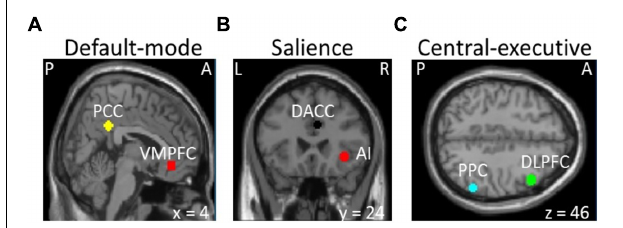
FIGURE 1 | Selection of the (A) default-mode (VMPFC, ventromedial prefrontal cortex; PPC, posterior cingulate cortex), (B) salience (AI, insula; DACC, dorsal anterior cingulate cortex), and (C) central-executive (DLPFC, dorsolateral prefrontal cortex; PPC, posterior parietal cortex) networks (P, posterior; A, anterior; L, left; R,